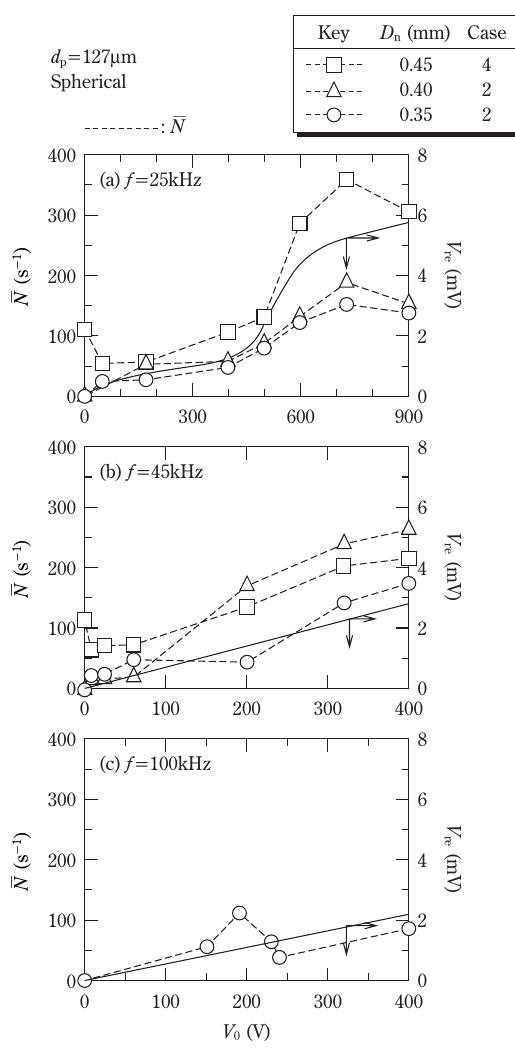
Fig. 6 Relationships between average discharge rate N (cid:3) , vs. applied voltage V 0 , and calibration curves of V re vs. V 0 for each fre- quency